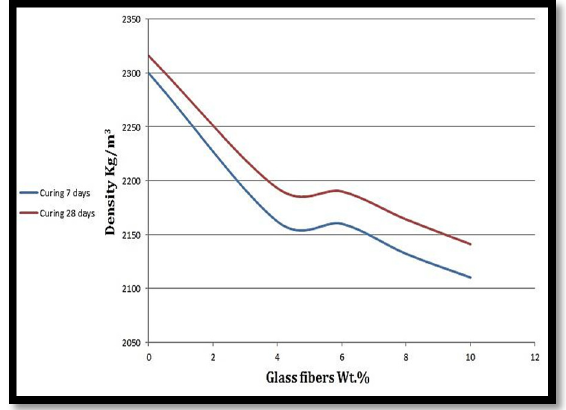
Fig. 3. Effect of glass fibers layers addition on the density of mortar without SBR